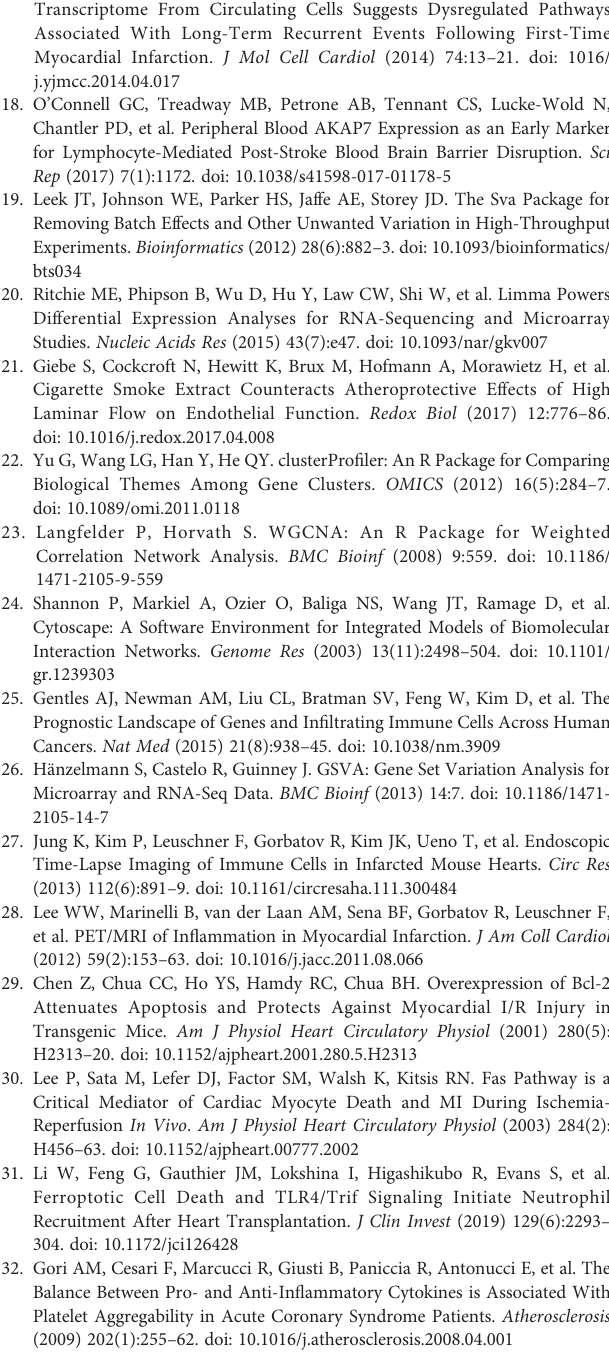
Supplementary Figure 4 – 9 | Pearson correlation coef fi cient between immune cells and apoptosis-related genes in (Left) AMI and (Right) IS. The Pearson correlation coef fi cient was determined by Pearson correlation analysis and the P-values were calculated by